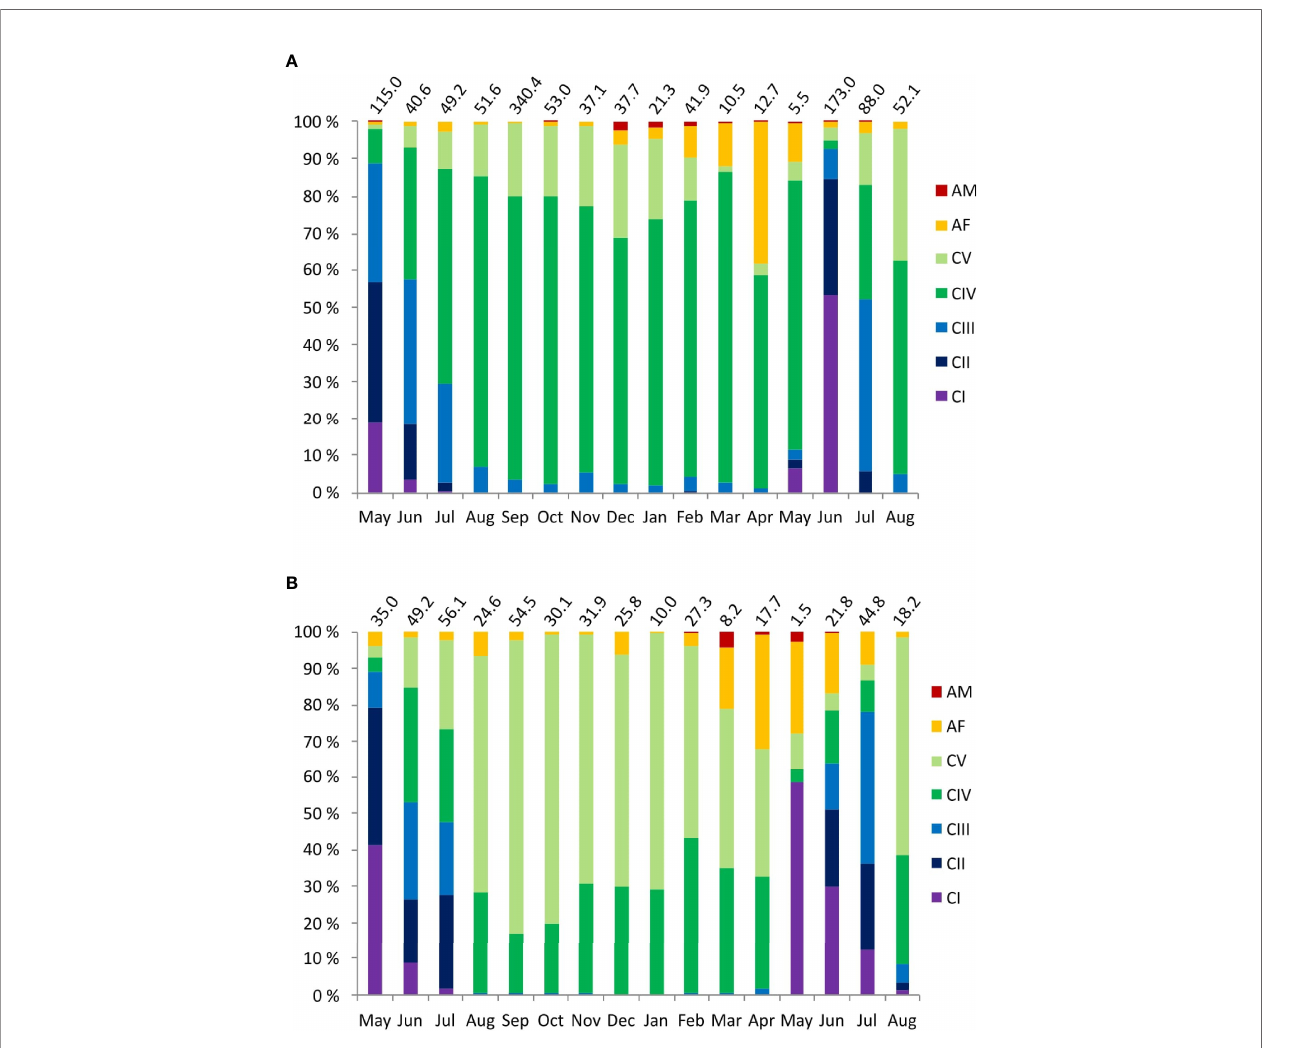
FIGURE 4 | Monthly changes in the relative copepodite stage composition of (A) C glacialis and (B) C fi nmarchicus at Karlskronadjupet, Isfjorden from June 2015 to August 2016. Total abundance (ind. m 2 ) each month is noted on top of each